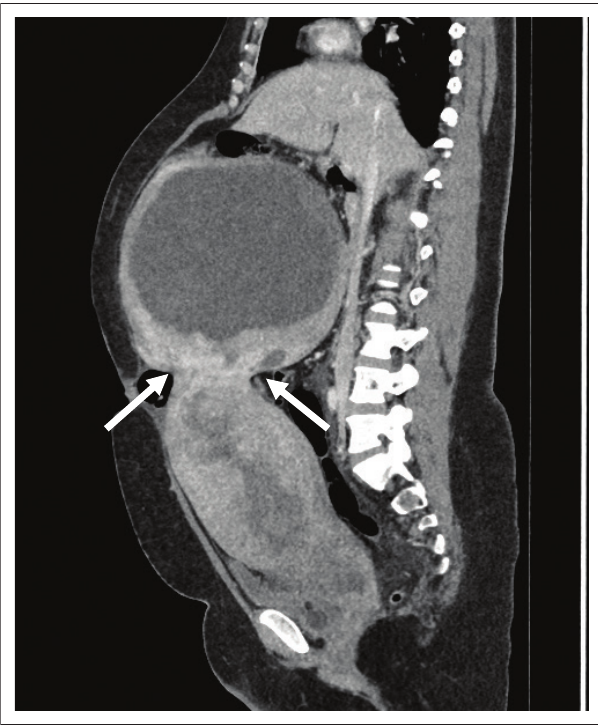
FIGURE 4: Poorly enhancing enlarged left ovary on axial portal venous computed tomography